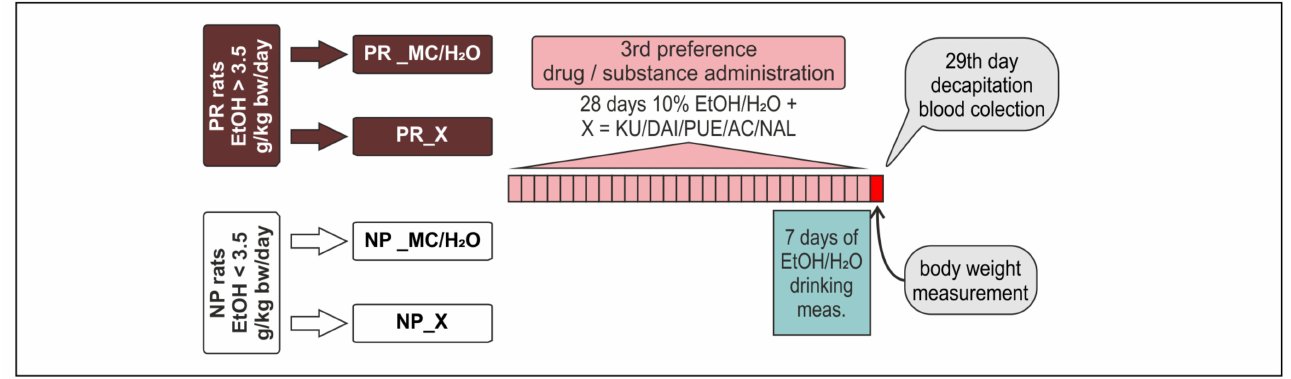
Scheme 2. Diagram of the division into test groups and the course of